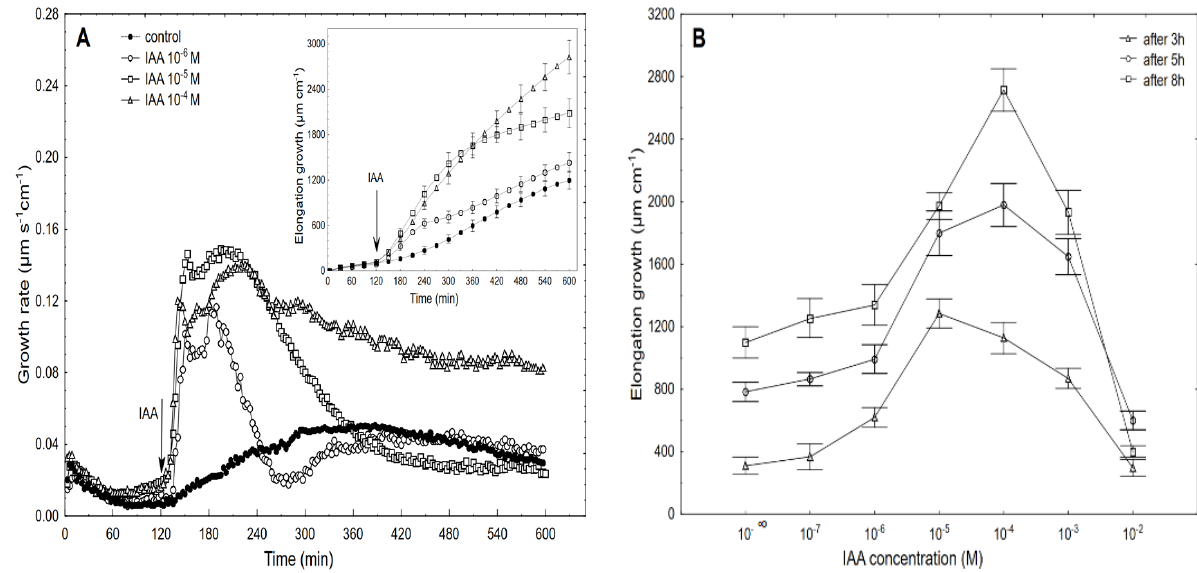
Figure 3. Growth rate ( µ m s − 1 cm − 1 ) of the maize coleoptile segments that had been incubated in the presence of 10 − 6 , 10 − 5 and 10 − 4 M of the IAA ( A ) and the dose-response curves for the IAA (10 − 7 –10 − 2 M)-induced total elongation growth of the coleoptile segments as a function of time ( B ). The coleoptile segments were first preincubated (over 2 h) in an auxin-free medium to which the IAA was added (arrow). The inset shows the total elongation growth ( µ m cm − 1 ), which was calculated as the sum of the extensions from 3 min interval measurements over 10 h. All of the curves are the means of at least six independent experiments. Bars indicate ± SE.